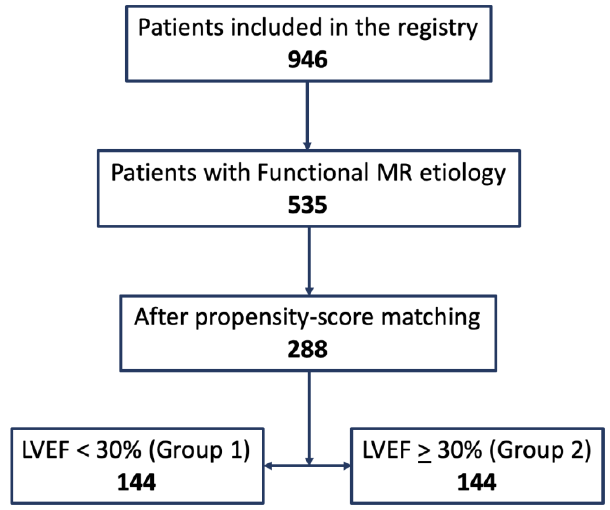
Figure 1. Flow chart of the design of the study.